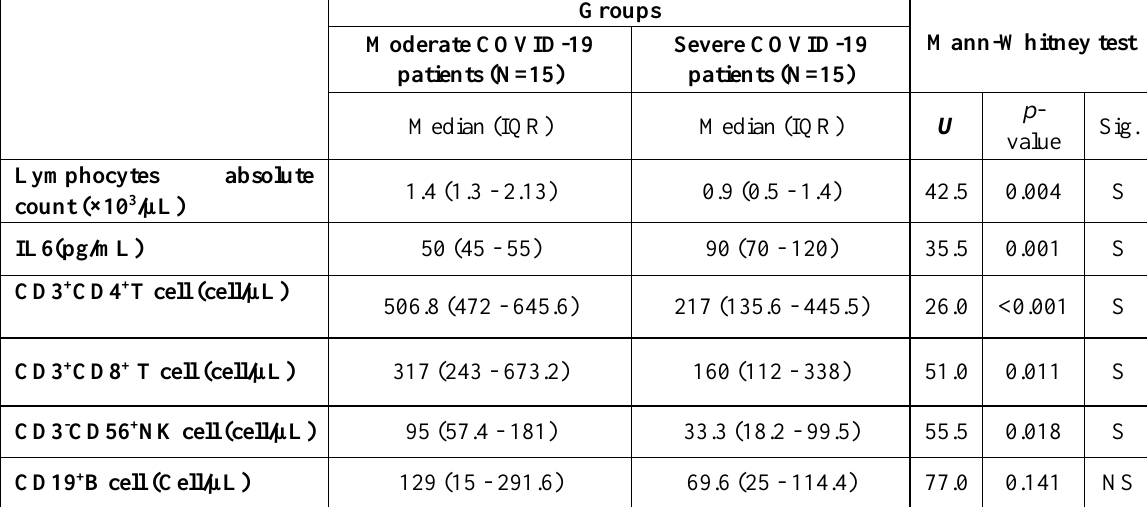
Table 2. Absolute lymphocytic count, IL6 serum level and lymphocyte cell markers measured in moderate and severe patients